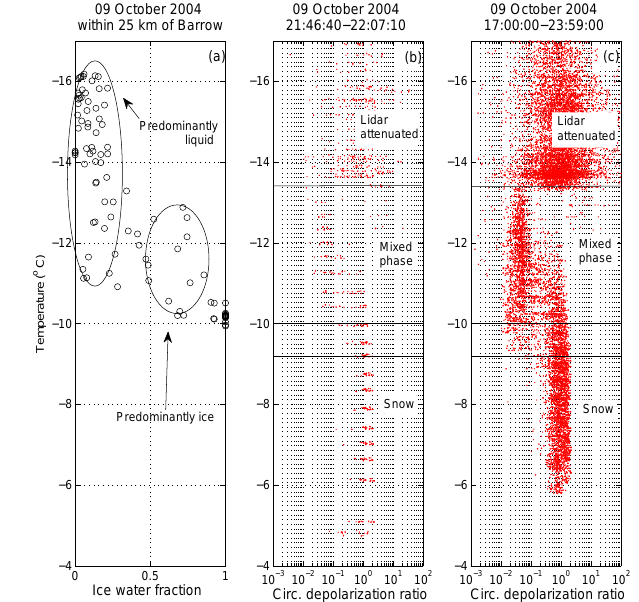
Figure 4. Profiles of (a) ice water fraction from aircraft, HSRL depolarization ratios for (b) the time of the in situ measurements and (c) for a longer period of time. Times listed are in UTC. Horizontal lines in (b) and (c) show the temperature thresholds used to divide data between snow and mixed phase, as well as indicating the region where the HSRL is attenuated and no longer gives a reliable signal.